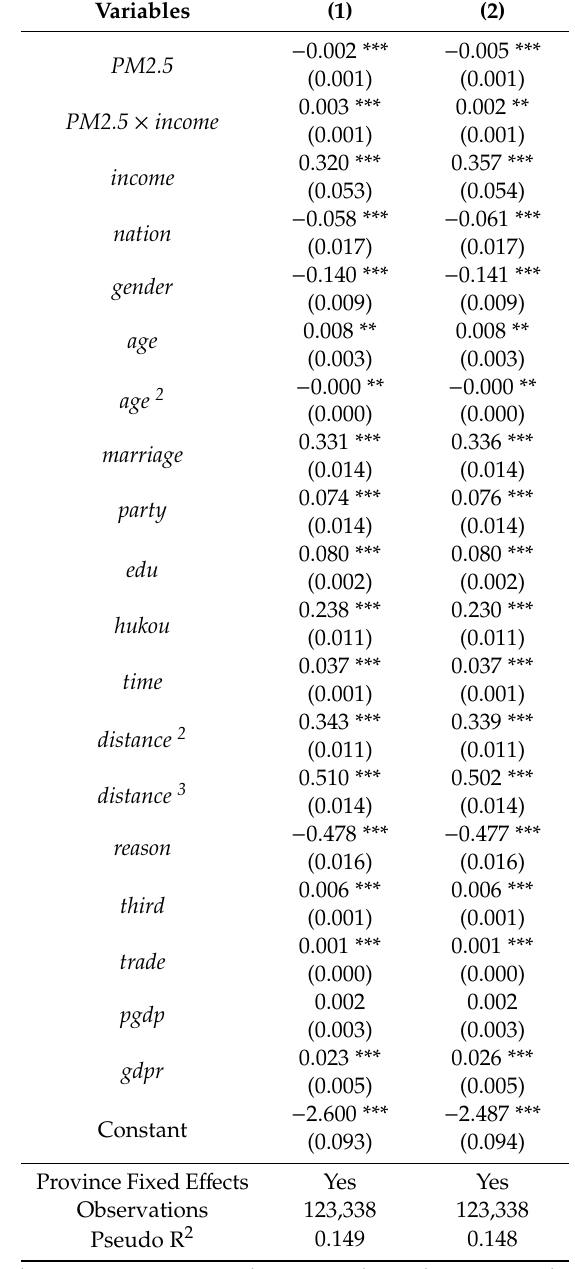
Table 6. Robustness test for the factors influencing the settlement intentions of Chinese migrants in cities using a probit regression model and the instrumental